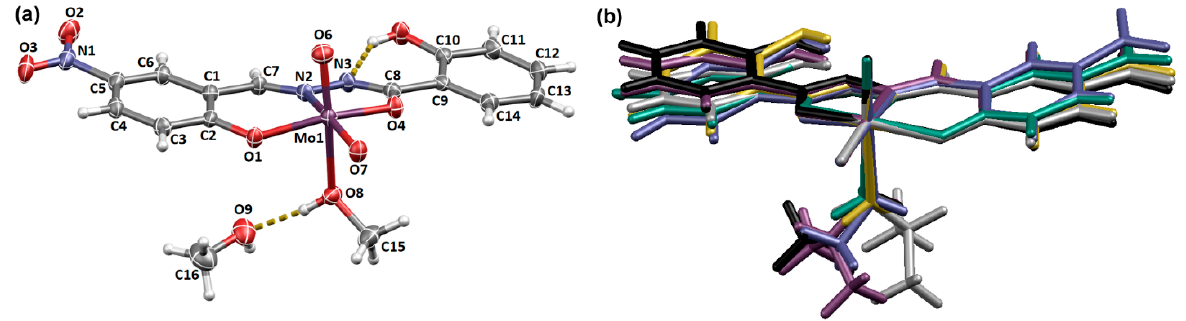
Figure 2. ( a ) Molecular structure with the atom-labeling scheme for [MoO 2 (L 1 )(MeOH)] ∙ MeOH. The displacement ellipsoids are drawn at a 50% probability level at 170 K. Hydrogen atoms are presented as spheres of arbitrary, small radii. The intramolecular hydrogen bonds of the O–H ∙∙∙ N type are highlighted as yellow dashed lines; ( b ) Overlay of the coordination entities: [MoO 2 (L 1 )(H 2 O)] (yellow), [MoO 2 (L 2 )(H 2 O)] (green), [MoO 2 (L 1 )(MeOH)] (blue), [MoO 2 (L 1 )(EtOH)] (black), and [MoO 2 (L 1 )(2-PrOH)] (molecule A, gray; molecule B, purple).